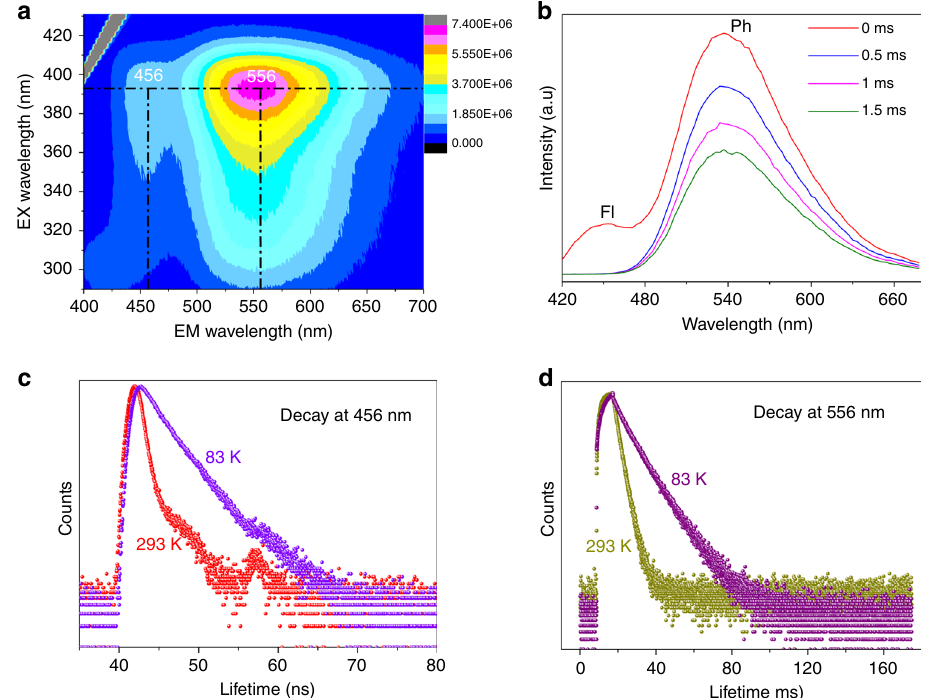
Fig. 2 Photoluminescence properties of Ag 12 bpy-NH 2 . a The three-dimensional excitation-emission matrix (3D-EEM) spectra of Ag 12 bpy-NH 2 under a vacuum at room temperature. The two emission centers are located at ~456 and 556 nm. b Prompt (0 ms) and time-delayed (0.5, 1, 1.5 ms) emission of solid-state Ag 12 bpy-NH 2 at room temperature under a vacuum. c Time-resolved Fl (456 nm) and d Ph (556 nm) decay traces of Ag 12 bpy-NH 2 under a vacuum at 293 and 83